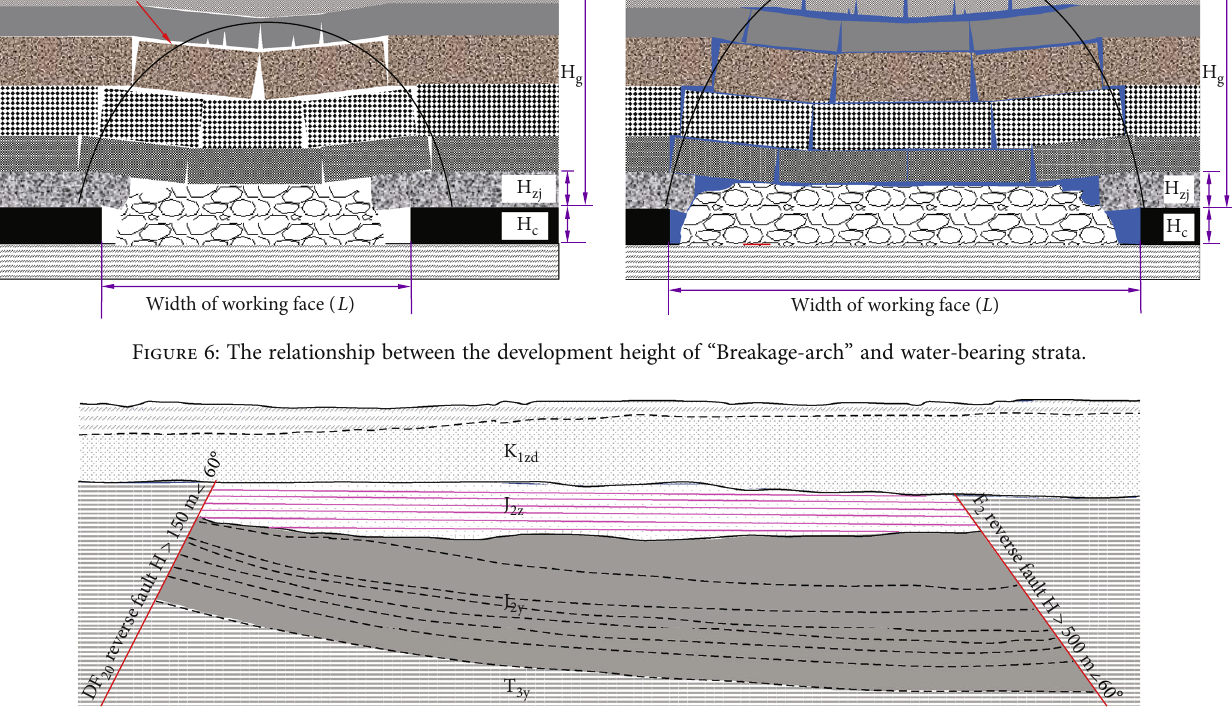
Figure 7: Geological pro fi le of mine fi